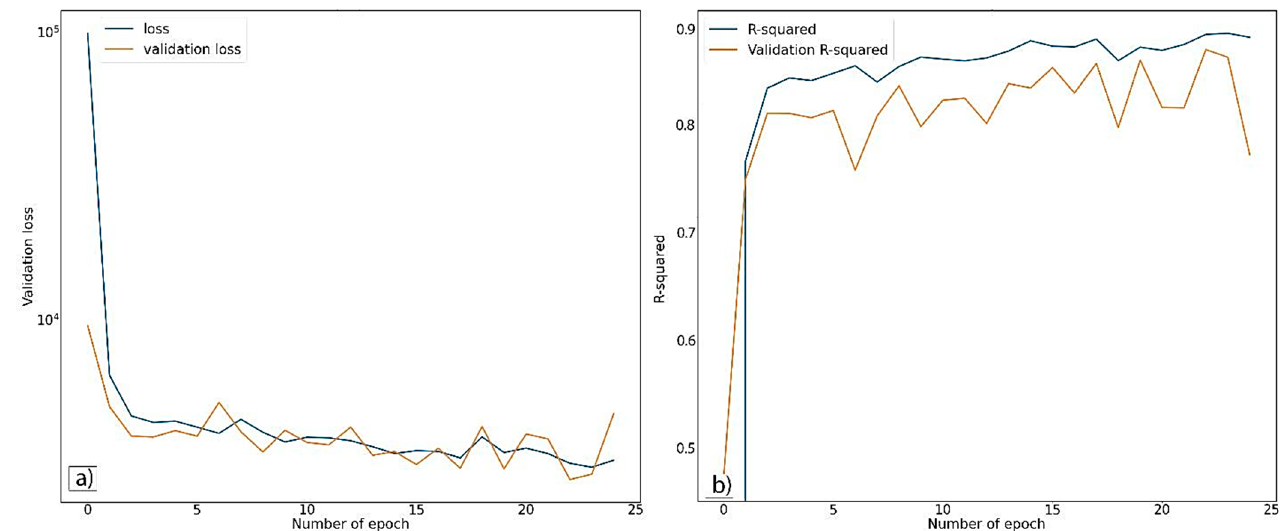
Figure 6. Improvement in the model prediction capability with the increase in the number of iterations, i.e., epochs, for the training and testing sets ( a ). The R 2 value is also shown as an indicator of the model performance ( b ).